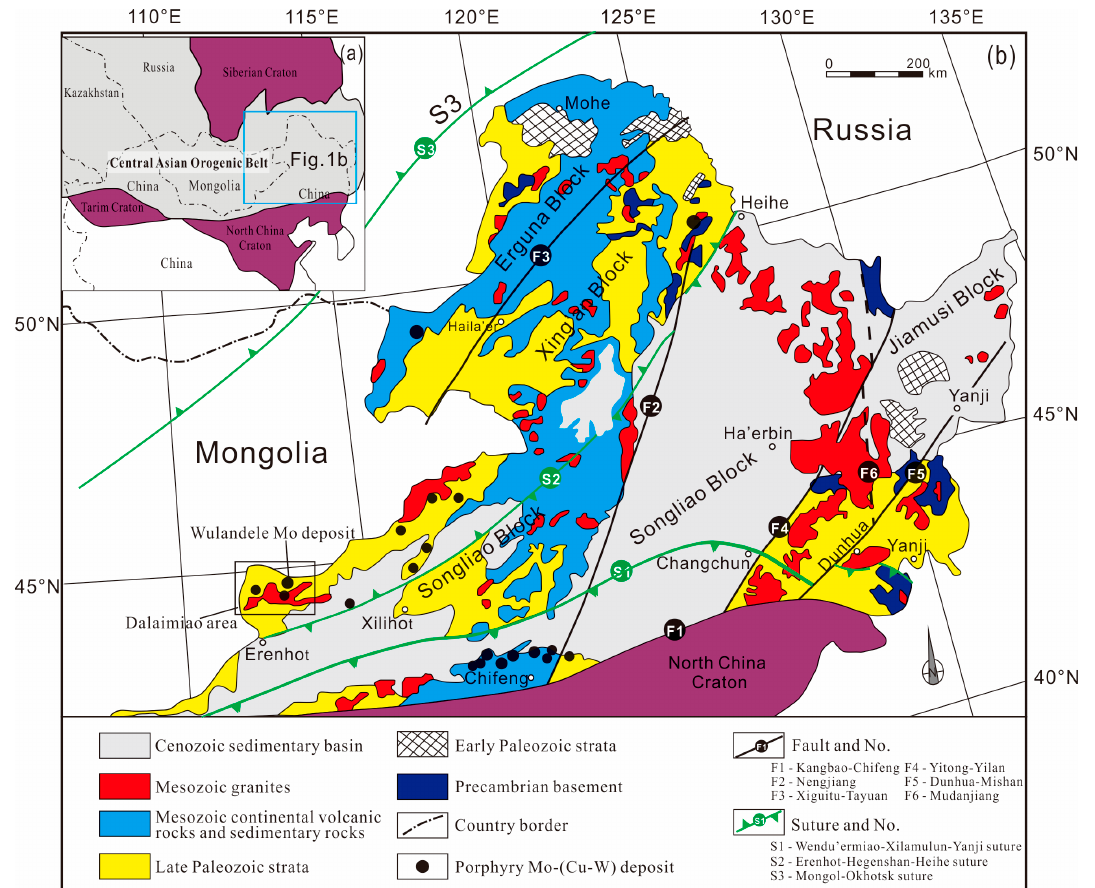
Figure 1. Regional tectonic map of the Xing’an–Mongolia Orogenic Belt in Inner Mongolia ( a after [10,12,13]). The insert is a simplified map showing the position of Xing’an–Mongolia Orogenic Belt in the eastern Central Asian Orogenic Belt ( b after [14]).